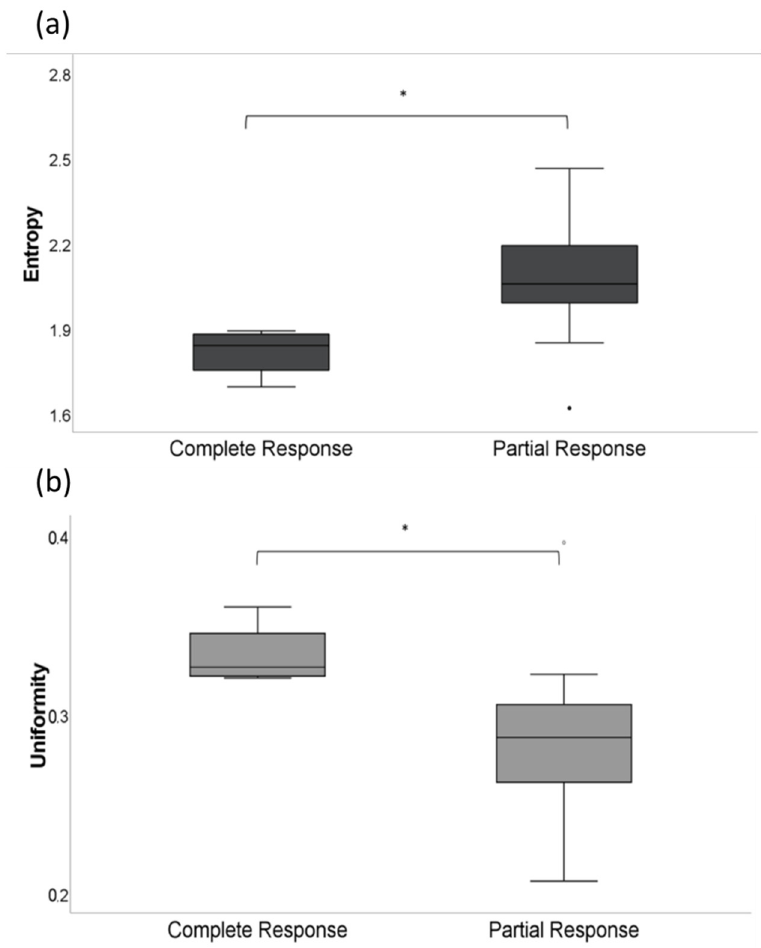
Figure 3. ( a ) Entropy at baseline imaging before CAR-T cell therapy in patients achieving CR (1.81 ± 0.1) vs. PR (2.08 ± 0.2; p < 0.05). ( b ) Uniformity at baseline imaging before CAR-T cell therapy in patients achieving CR (0.33 ± 0.02) vs. PR (0.28 ± 0.47; p < 0.05). The asterisk (*) indicates clinical significance ( p < 0.05).